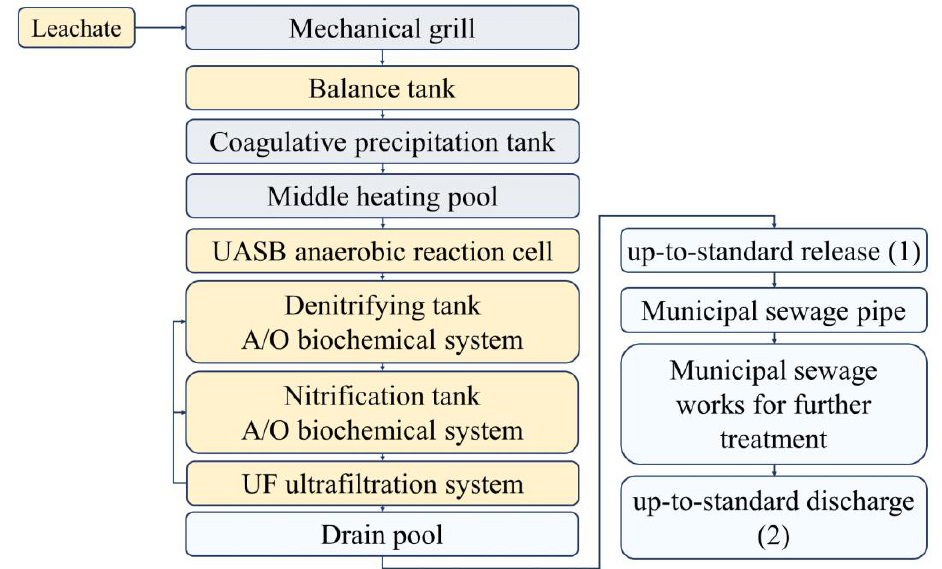
Figure 1. Process flow diagram of incineration leachate treatment in the study.